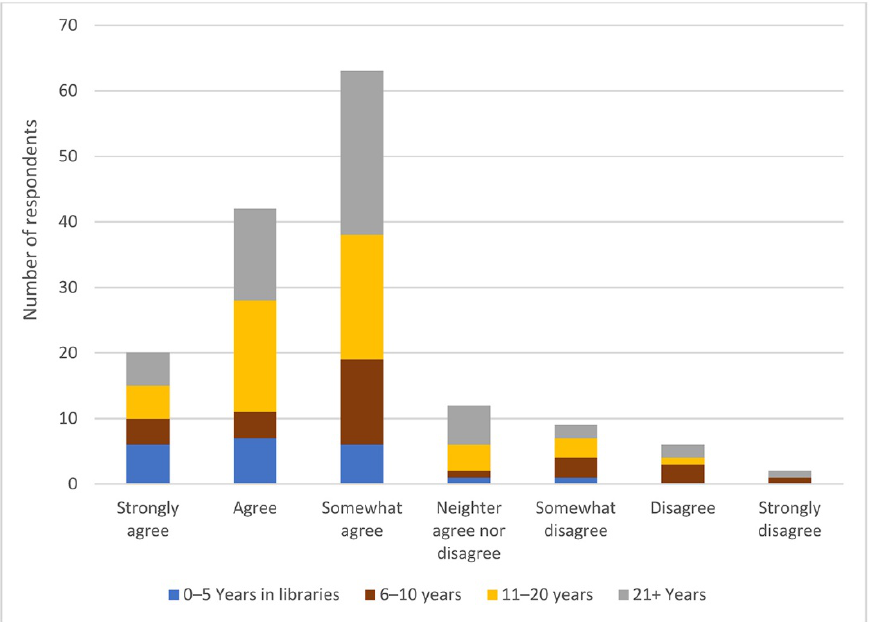
Figure 2 Respondents’ belief that age and/or generation has an impact on communication in the workplace based on years worked in a